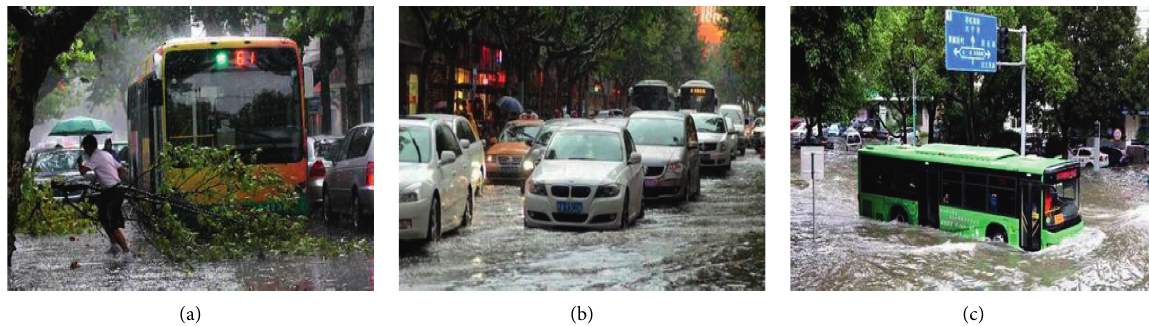
Figure 2: Hypothetical road waterlogging scenarios in the storm. (a) Scenario 1, (b) Scenario 2, and (c) Scenario